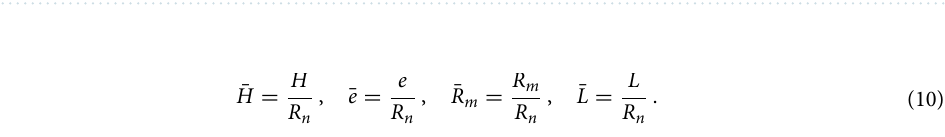
Table 2. Dimensionless equivalent radii obtained in transient, as defined in Fig. 6, and with the quasi-static